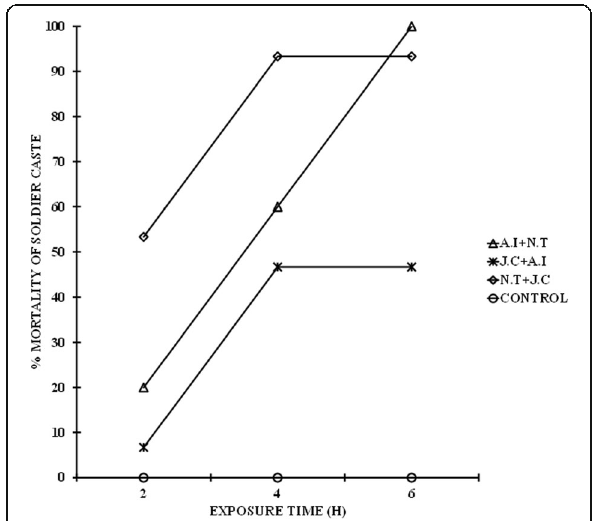
Fig. 3 Percentage mortality of soldier caste of Macrotermes subhyalinus on filter papers treated with bi-mixed aqueous extracts. A.I+N.T = Azadirachta indica plus Nicotiana tabacum. J .C+A.I =